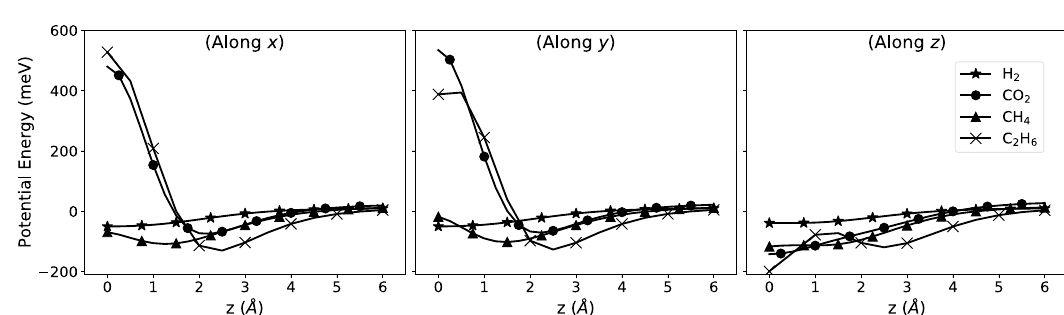
Figure 5. Density profiles and survival probability correlation functions of the gases near the graphyne-3 membrane, located at z = 0 , as shown in Fig. 2b. H 2 spends the least amount of time, compared to others, which indicates its fast transport through the membrane.